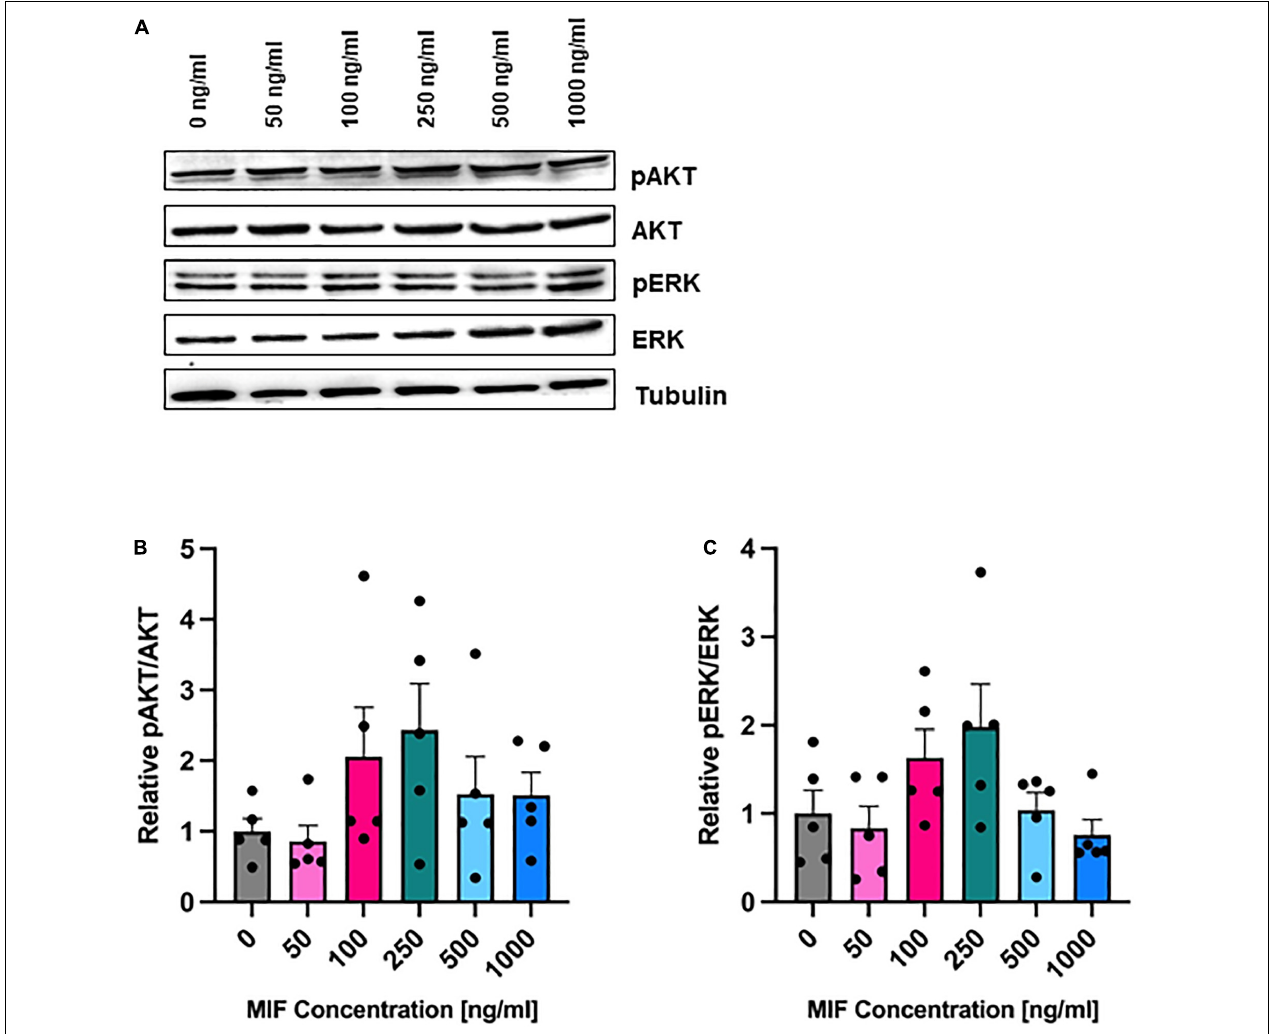
FIGURE 6 | AKT and ERK phosphorylation after MIF stimulation. ASCs were cultured in growth medium at normoxic oxygen levels of 21% O 2 for 24 h and then stimulated with various concentrations of exogenous MIF for 15 min. The control (0 ng/ml) did not receive any exogenous MIF. Cell lysates were obtained and Western blot analysis was performed and evaluated using the AIDA software. Tubulin was detected for total protein standardization. (A) Blots are representative of all Western blots performed to detect levels of AKT and ERK activation. Analyses were performed on five biological replicates ( n = 5). Graphs display (B) relative pAKT/AKT and (C) relative pERK/ERK normalized to the activation level of unstimulated cells set to one. Data are mean values ± SEM (one-way ANOVA, Holm-Šídák’s multiple comparisons test, not